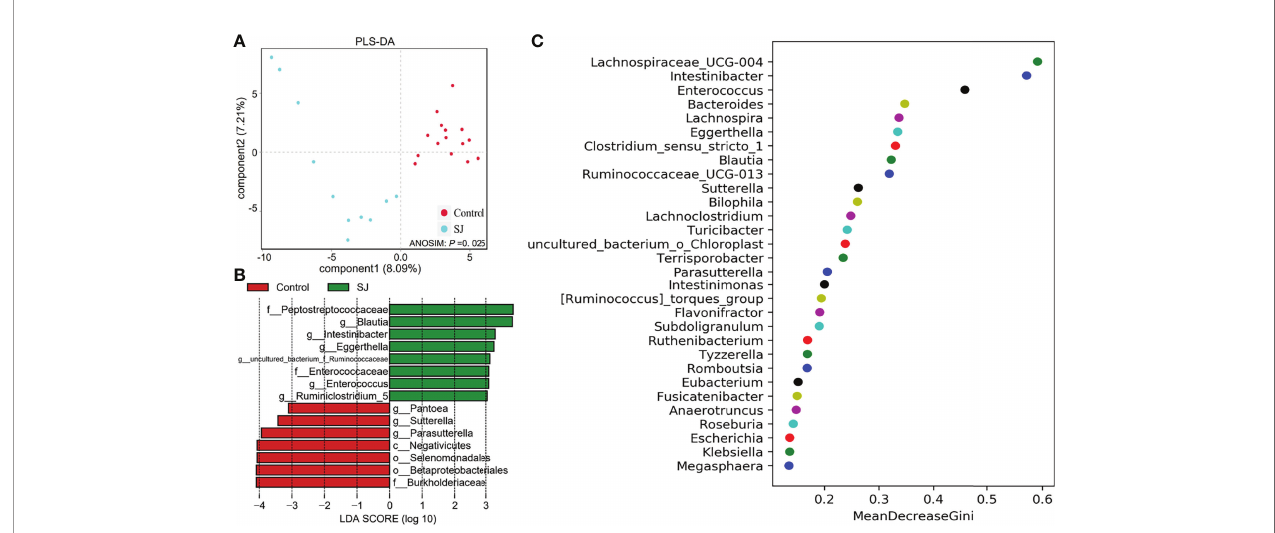
FIGURE 4 | Identi fi cation of gut microbial biomarkers in S. japonicum- infected (n = 11) and uninfected (n = 15) humans. (A) PLS-DA plot. (B) Differential gut bacterial taxa analyzed by LEfSe analysis with LDA score >3 between groups. (C) Top 30 of different gut microbes between populations are shown. Control, without S. japonicum infection humans. SJ, S. japonicum- infected